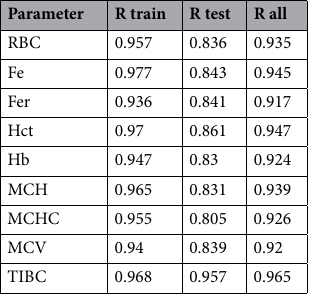
Table 3. R value for training and